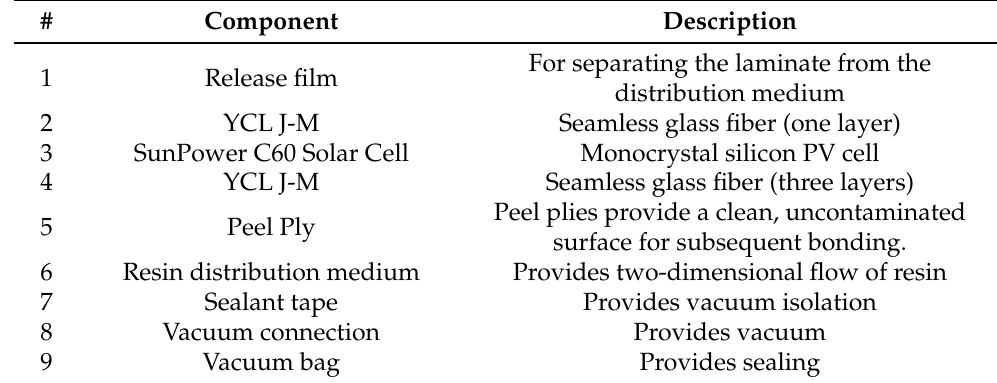
Table 2. Components of the VARTM lamination process.